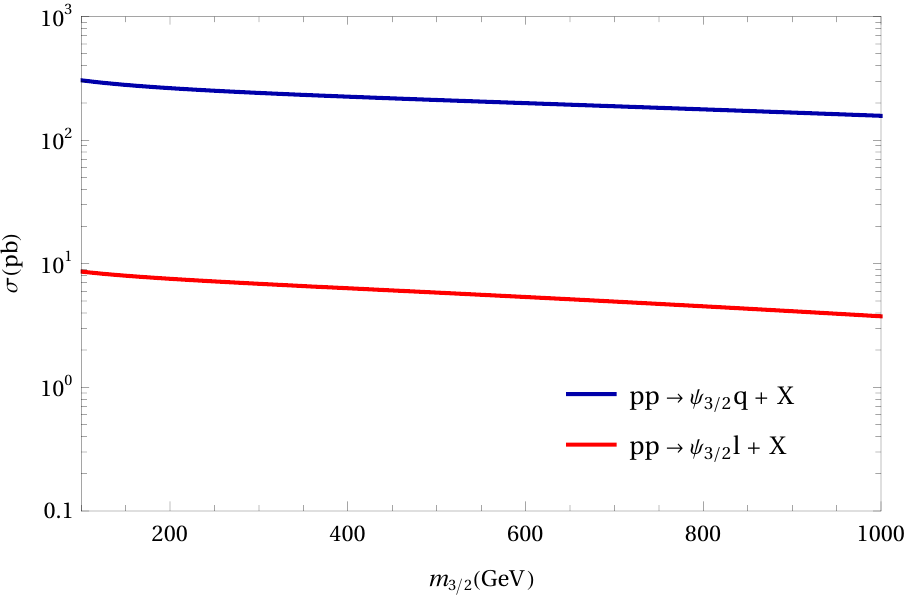
Figure 3 . The single production cross sections of ψ as a function of m 3 / 2 pp → ψ q + X and pp → ψ ν + X corresponding to the point-like partonic processes qq → ψ 3 / 2 3 / 2 √ and q ¯ q → ψ ‘ at the LHC with s = 14 TeV. The effective Hamiltonian parameters have been 3 / 2 set to Λ = 1 TeV and c q = c lq = 1